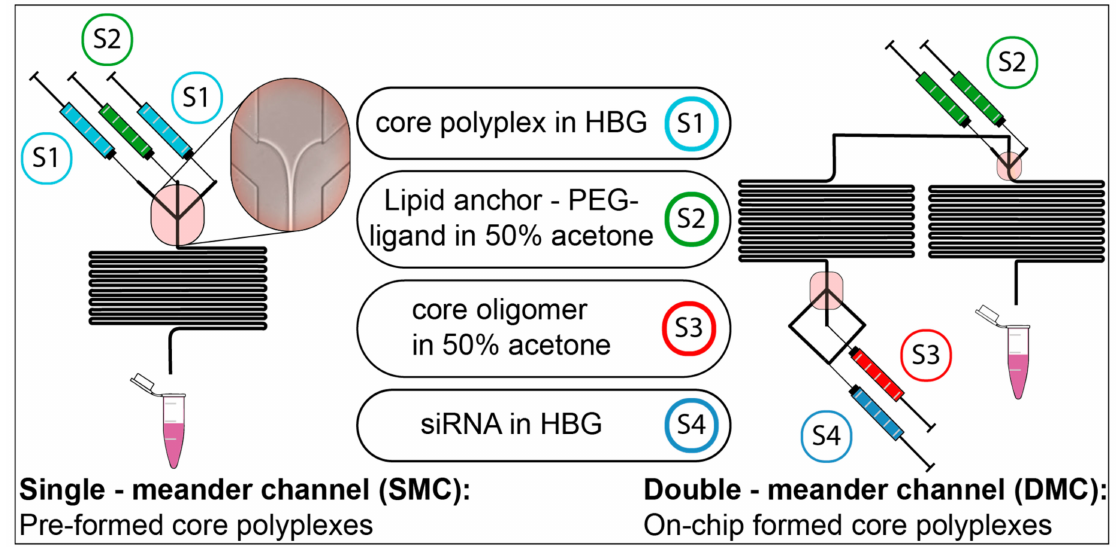
Figure 1. Production methods for polyplexes from oligomers and siRNA. Formulation components used are depicted with the id label of their corresponding syringe (S1–S4). Two different channels were used to produce nanoparticles during solvent exchange, a single meander channel (left) and a double meander channel (right). In the single meander channel, pre-assembled core particles (S1) were mixed with lipid anchor polyethylene glycol (PEG)-ligand oligomer (S2). In the double meander channel, the polyplex was assembled by microfluidics in two subsequent steps from its starting components (S3, S4, S2). PEG: polyethylene glycol. HBG: HEPES buffered glucose pH 7.4. Core oligomer (S3): cationic lipo-oligomer. Lipid anchor-PEG-ligand (S2): oligomer containing fatty acids to hydrophobically adsorb to the core oligomer, a PEG chain and folic acid as ligand for the folate receptor. Core polyplex (S1): polyplex from siRNA (S4) + core oligomer (S3). Reproduced with modification from Loy et al., 2019 [30], https://doi.org/10.7717/peerj-matsci.1/fig-1. under copyright permission from